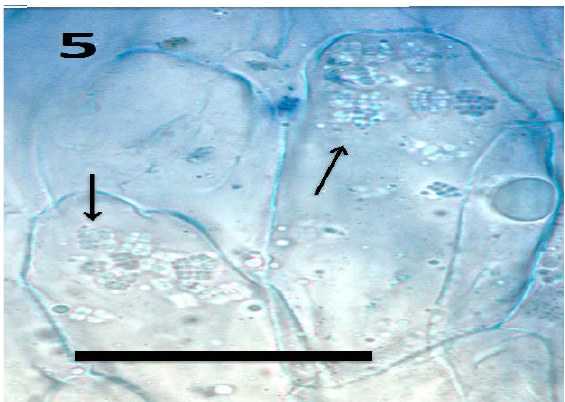
Figure 5. Tomato seedling root epidermis showing internal presence of tetrads (arrows) of Micrococcus luteus (bar = 20 µm; stained with aniline blue).